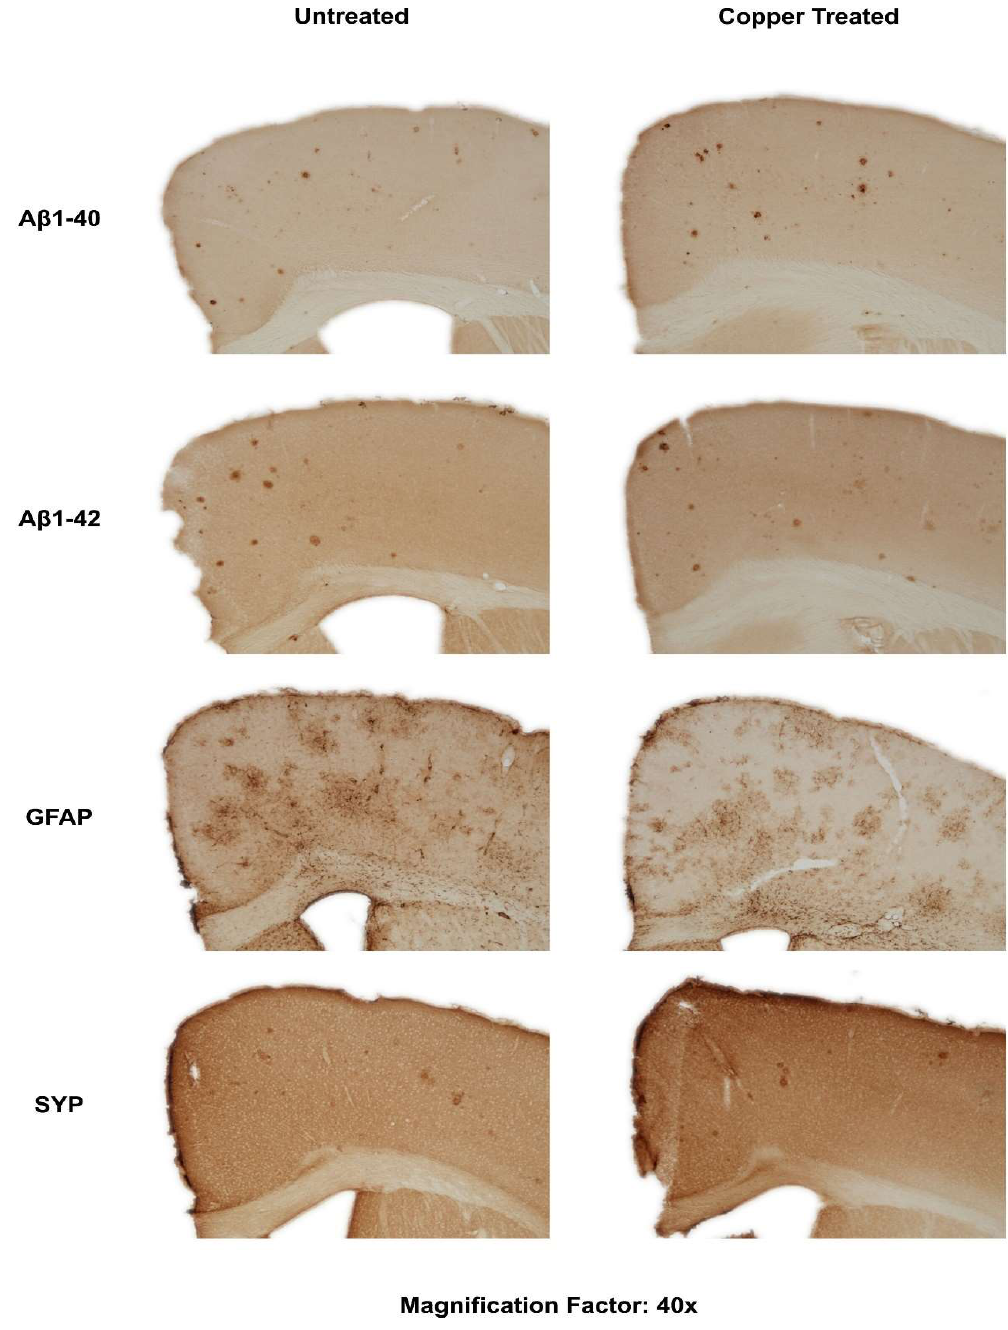
Figure 3. Dietary Cu exposure enhanced cerebral A β amyloid pathology in APP / PS1 transgenic mice. Representative coronal brain sections (at the anterior commissure level) from APP / PS1 transgenic mice on regular and Cu-enhanced diets for 24 days. They were immunostained for A β 1-42 and A β 1-40, illustrating the size, number and distribution of A β amyloid plaques. The immunostaining for reactive astrogliosis marker- GFAP and negative staining for SYP, a marker for neuronal synaptic activity, were also performed.